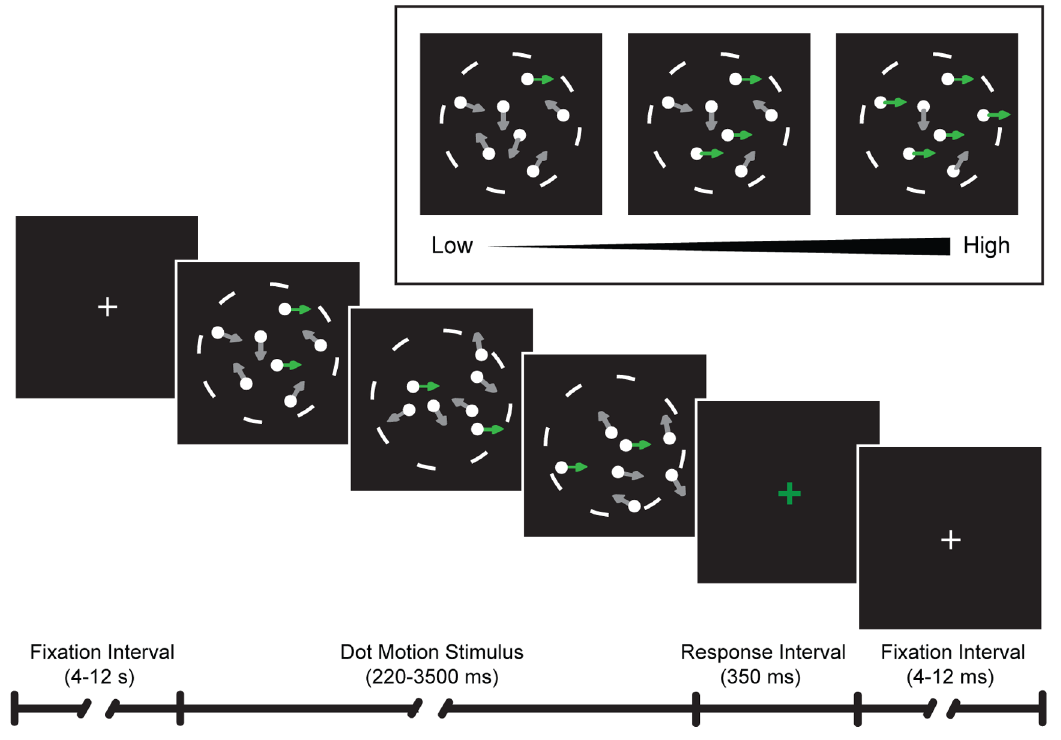
Figure 1. Task Design. Each trial consisted of a dot motion coherence stimulus displayed for 220 to 3500 milliseconds, with duration determined by the experimenter and defined by a gamma distribution equating the hazard rate across trials (see Methods). The motion coherence of the stimulus was also varied across trials (inset). To indicate that a response was required, the dot motion stimulus disappeared and a green fixation cross was displayed, after which subjects had 350 milliseconds to respond.